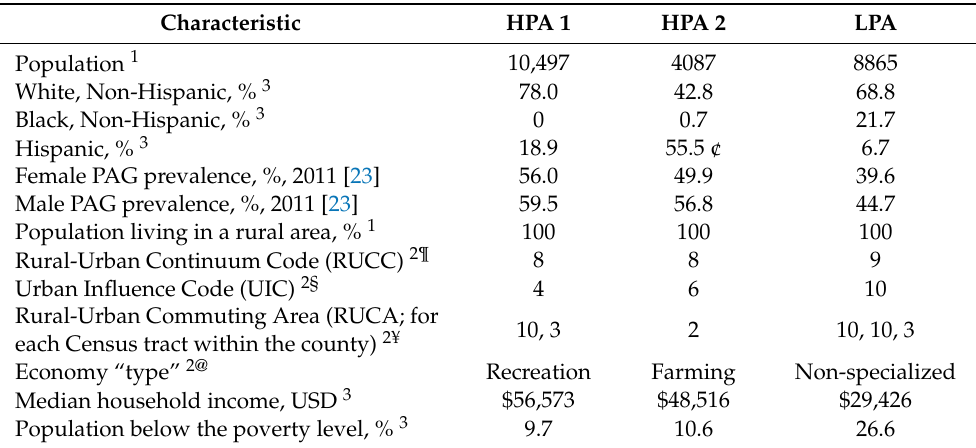
Table 1. Characteristics of the three rural southern US counties where data were collected,